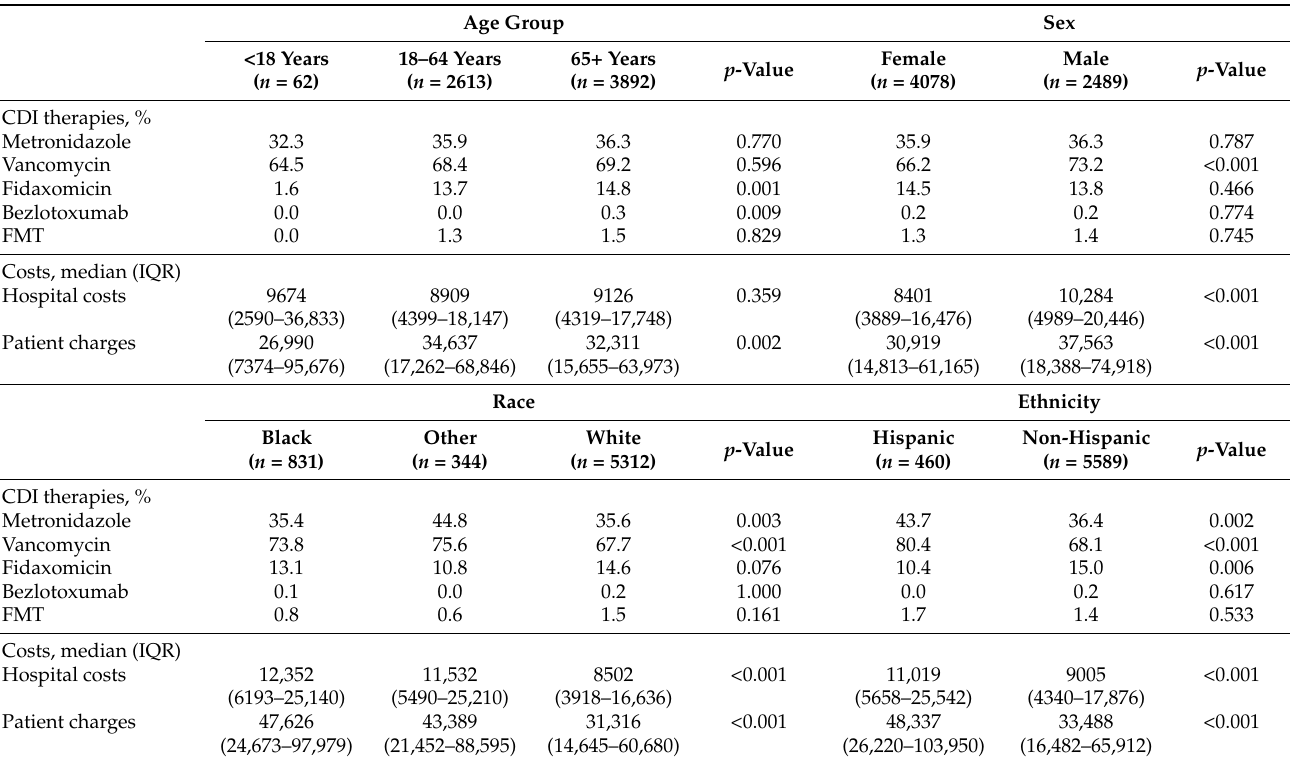
Table 3. CDI treatment patterns by patient subgroups for recurrent CDI encounters.